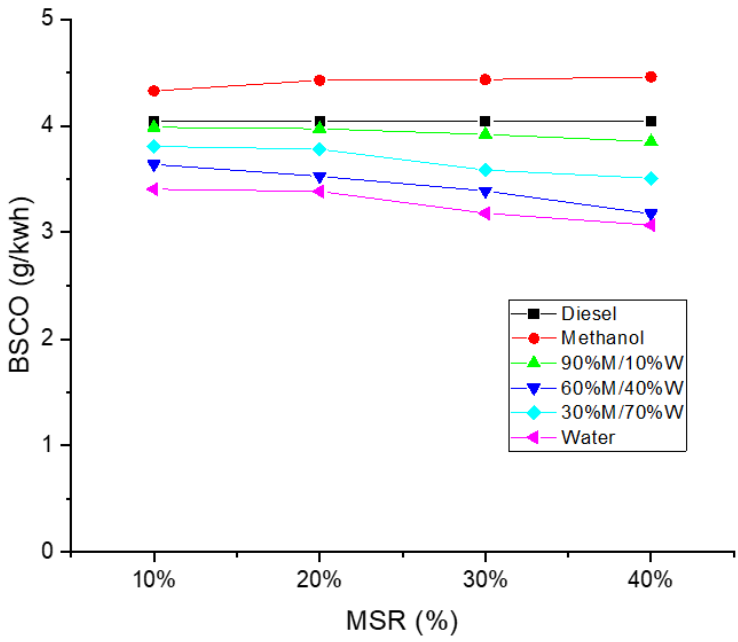
Figure 8. Changes in CO emissions with different fuel mixture ratios.